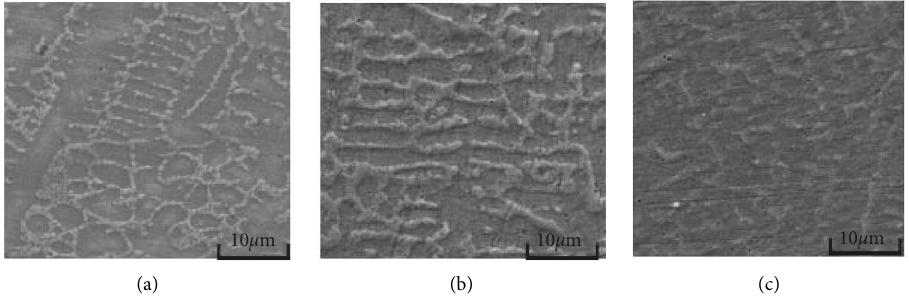
Figure 9: SEM images showing microstructure of the three samples: (a) SEM image of test specimen 1; (b) SEM image of test specimen 2; (c) SEM image of test specimen 3.